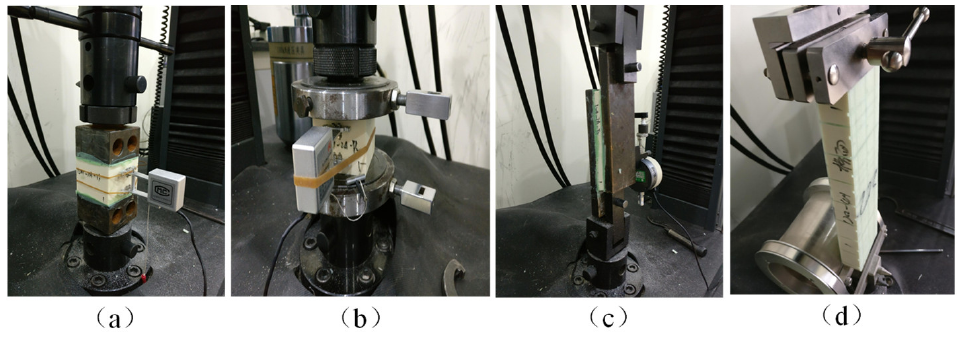
Figure 4. The in-site pictures of the tests: ( a ) tension, ( b ) compression, ( c ) shear, and ( d ) drum peel. The loading speeds were 1.0, 2.0, 1.0, and 25.4 mm/min for tensile, compressive, shear, and peel tests, respectively. The ambient temperature and relative humidity during the test period were 20–22 ◦ C and 47–52%,